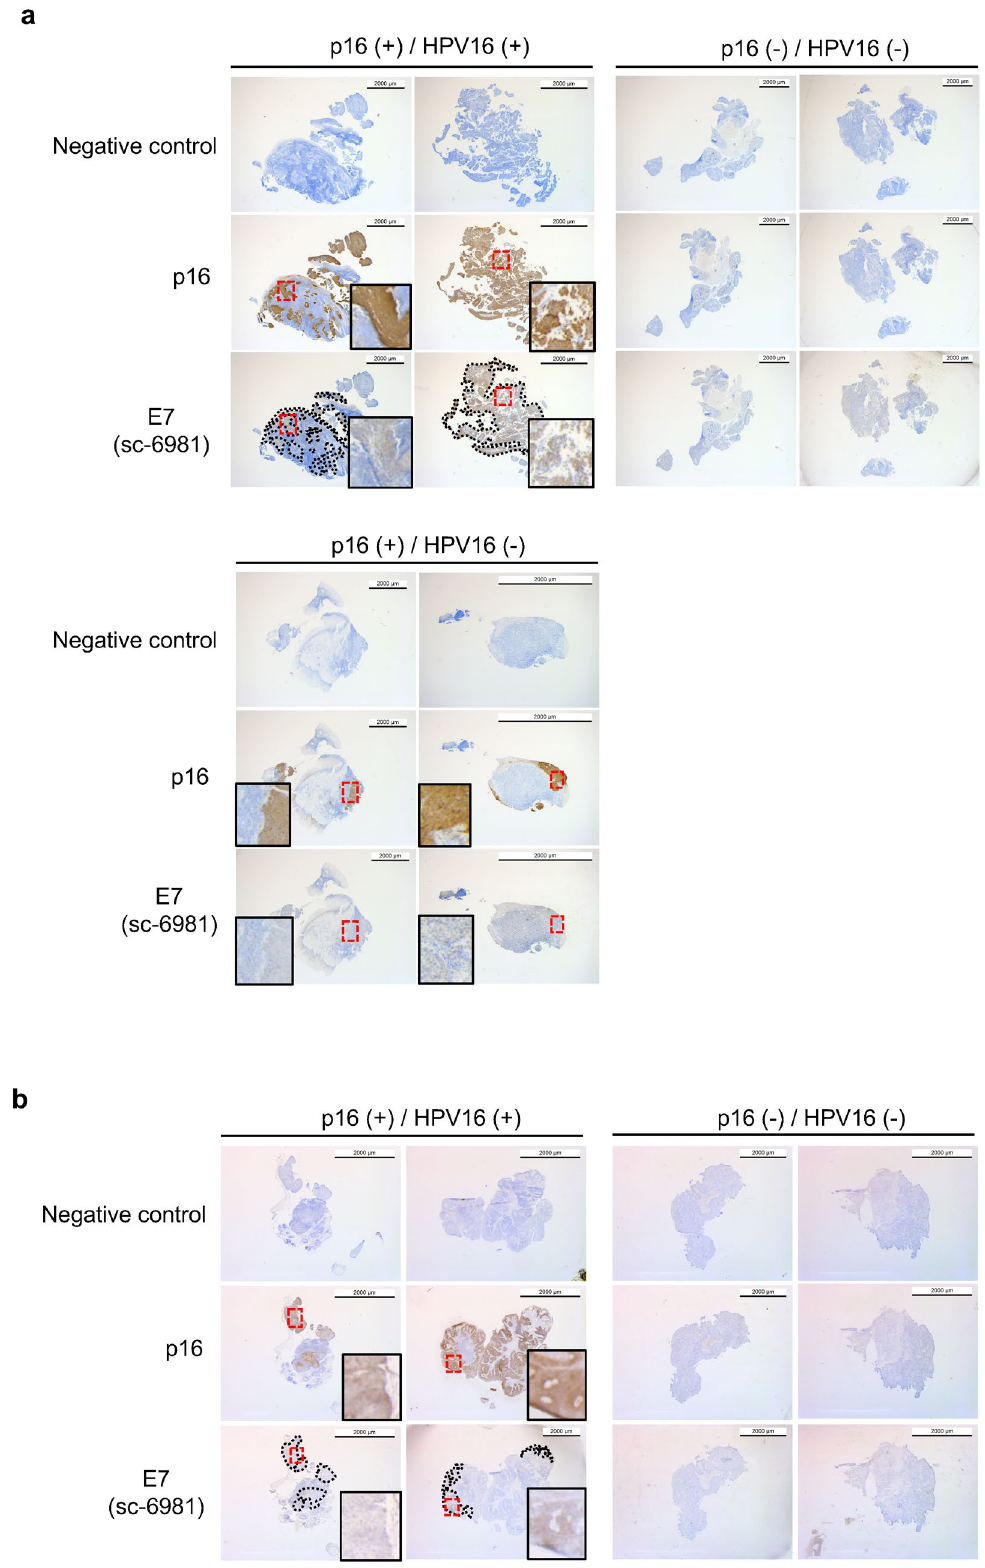
Figure 5. Immunohistochemical analysis of E7 protein in clinical samples of HPV16 (+) and HPV16 (−) oropharyngeal carcinoma. ( a ) Formalin-fixed and paraffin-embedded samples were stained using the indicated antibodies. ( b ) Frozen samples were stained using the indicated antibodies. Scale bar 2